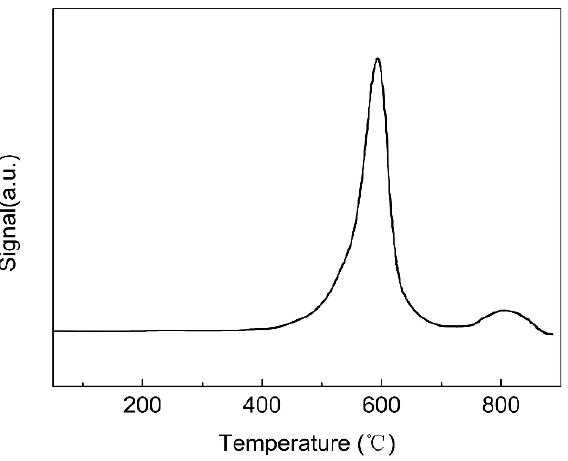
Figure 8. H 2 -TPR test results of the alloy catalyst heated at 10 °C min − 1 with 10% H 2 /Ar gas